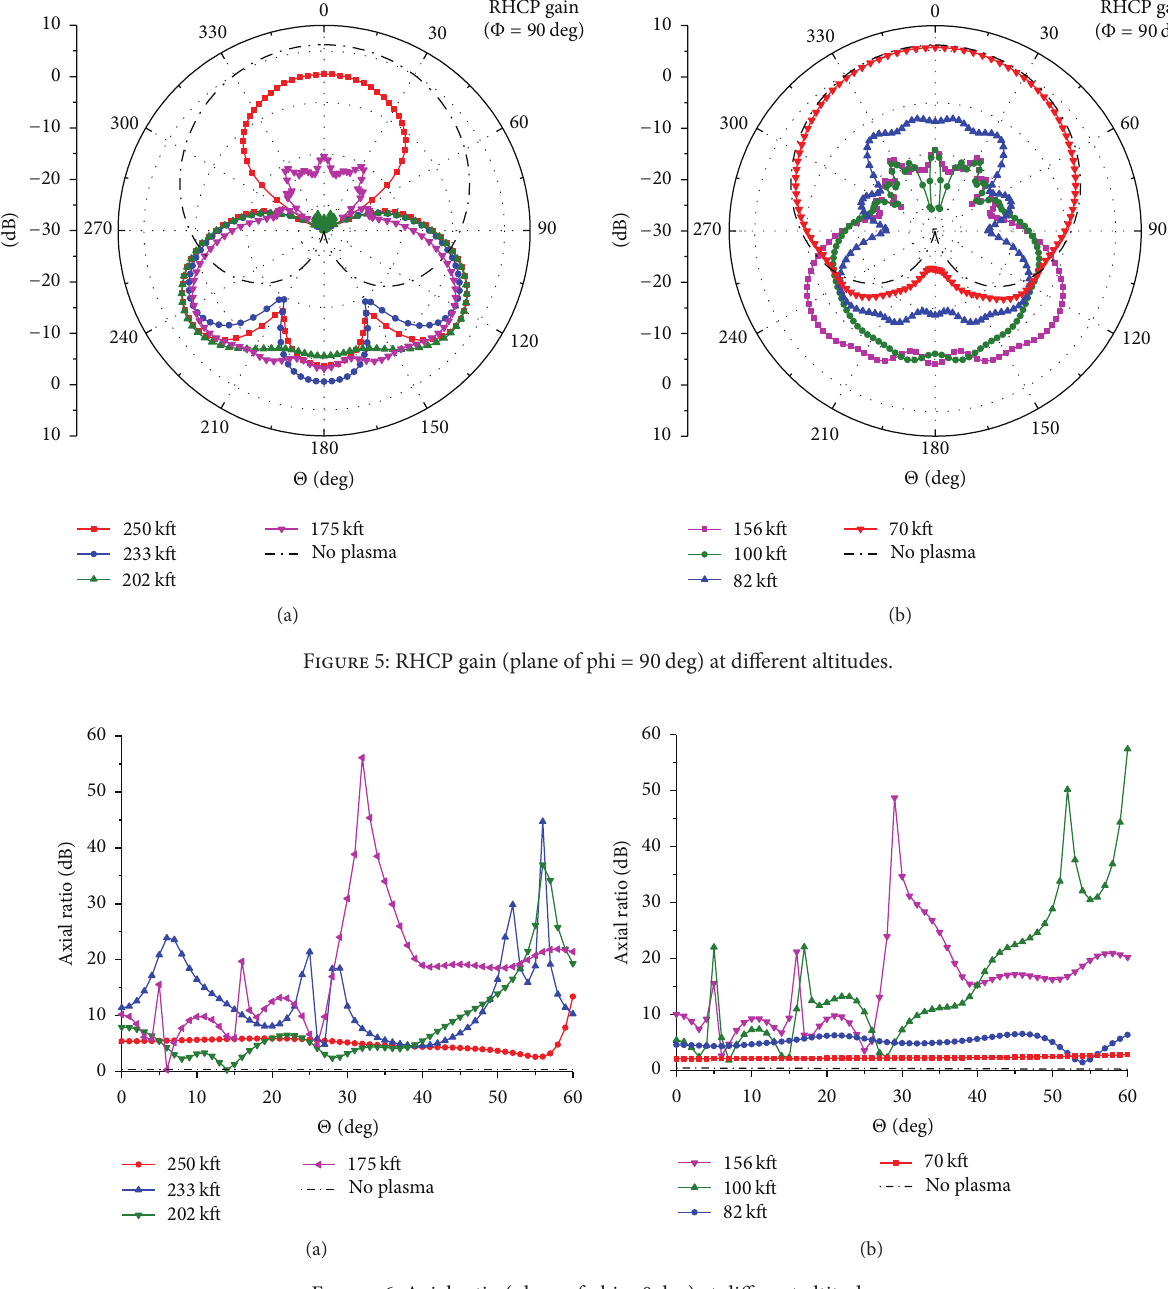
Figure 6: Axial ratio (plane of phi = 0deg) at different